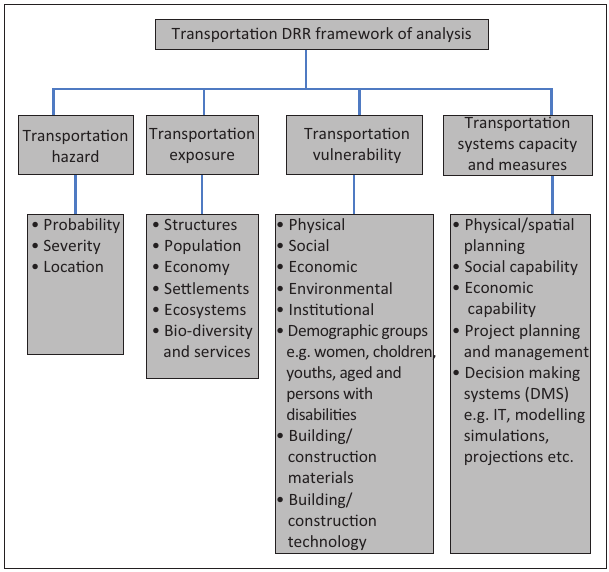
FIG URE 4: Transportation disaster risk reduction framework of analysis.